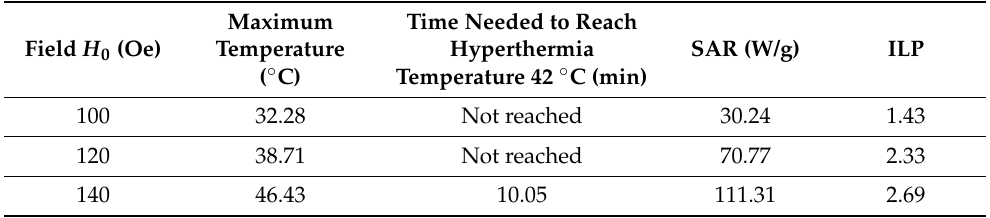
Table 2. Heating characteristics for Fe 3 O 4 MNPs (5 mg/mL) at different field amplitudes and f = 332.8 Table 3. Heating characteristics for Fe 3 O 4 MNPs (5 mg/mL) at different frequencies and field am- plitudes H 0 = 120 Oe.